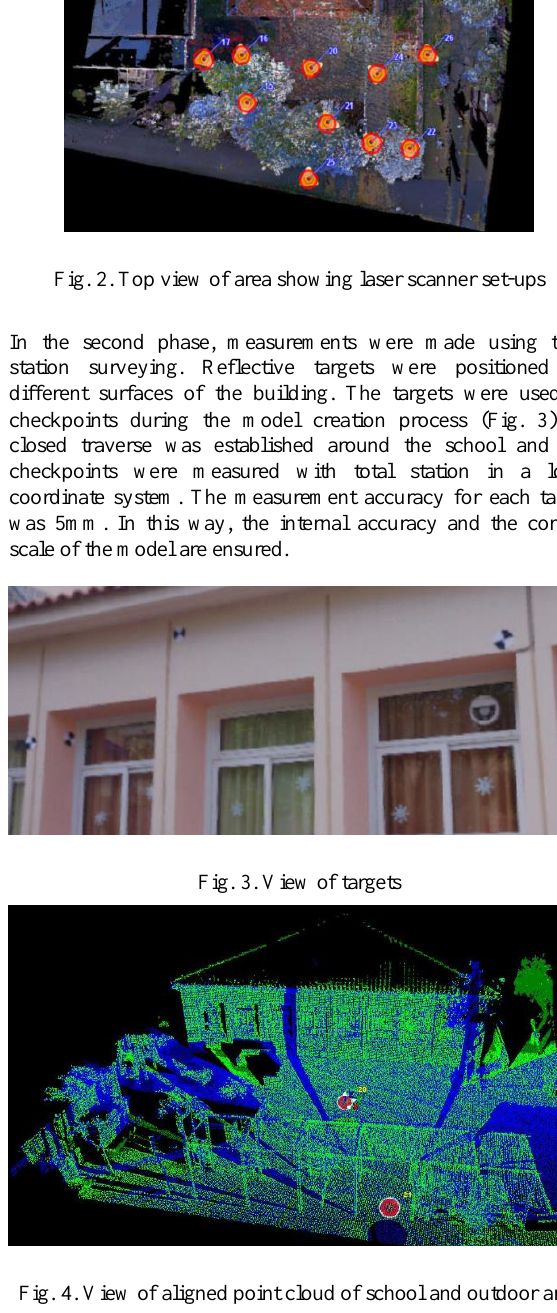
Fig. 4. View of aligned point cloud of school and outdoor